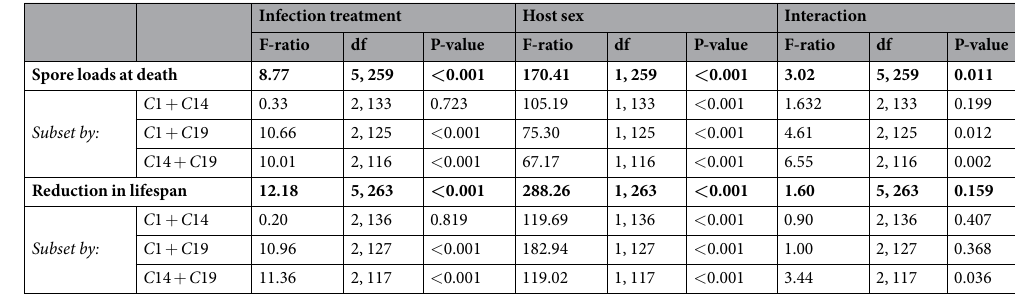
Table 1. Influence of host sex and co-infection on the production of transmission spores, and the relative reduction in host lifespan. In bold are the overall tests using the entire dataset for the influence of host sex on the outcome of all infection treatments (all single and co-infections together). Below these are the individual analyses for each co-infection